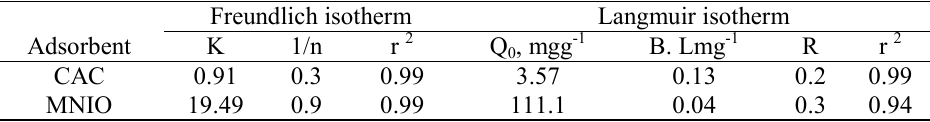
Figure 10. Application of Freundlich and Langmuir isotherm for removal of the Ni(II) ion by CAC and SNIO. Table 2. Freundlich and Langmuir constants derived from the simultaneous removal of Ni(II) ion by using CAC and